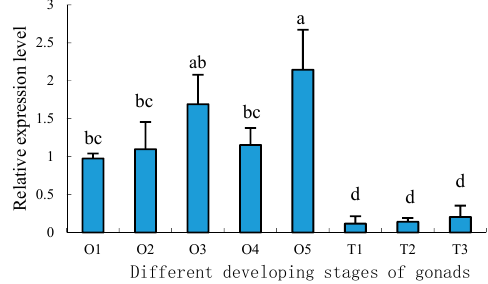
Figure 10. Distribution pattern of Sp-uchl5 in different developing stages of gonad. O: ovary, T: testis, number: stage of development. The lowercase letters above error bars signify difference as follows: The same letters are not significantly different ( p > 0.05), the adjacent letters are significantly different ( p < 0.05), and the intervallic letters are extremely significantly different ( p < 0.01).